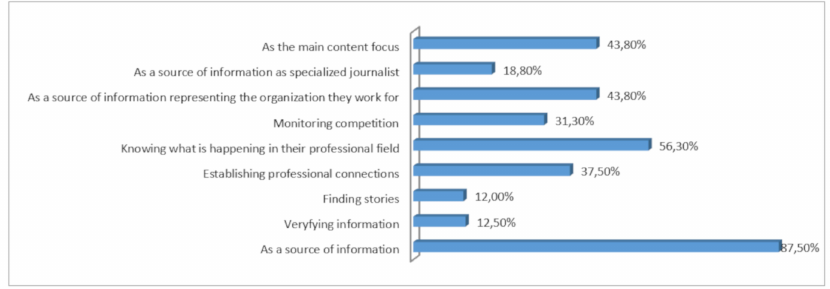
Figure 4. Main aims in the use of social media. Source: In-house elaboration.